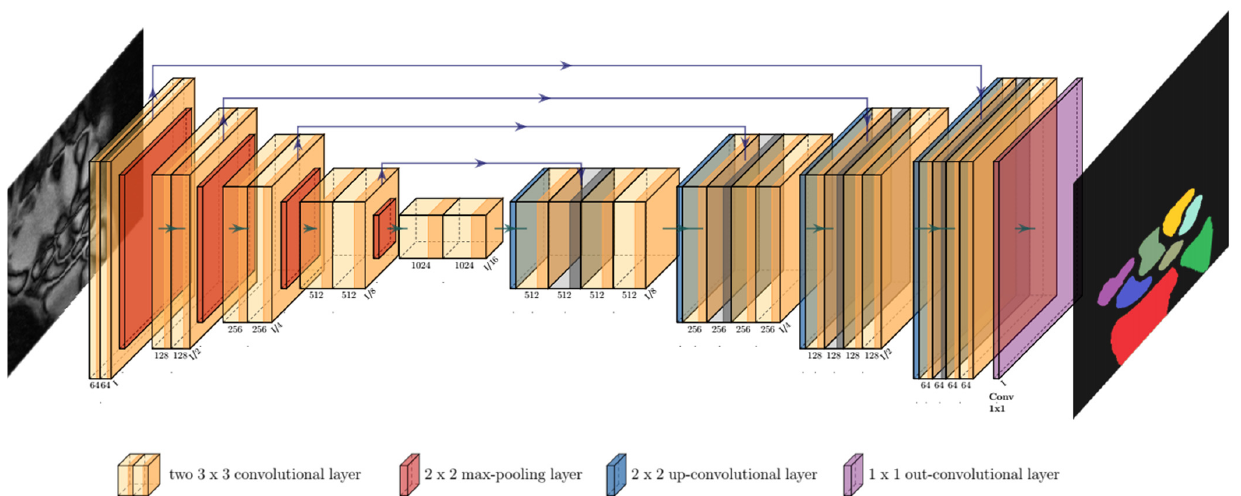
Figure 3. Convolution of an input MR image (left) inside the U-Net architecture and visualization of resultant bone segmentations as its output (right). The number of channels is indicated under each convolutional layer. The reduction and increase of the image resolution are indicated at the end of a block normalized to I = input size. Color-codes of the output image correspond to the different classes of semantic segmentations.